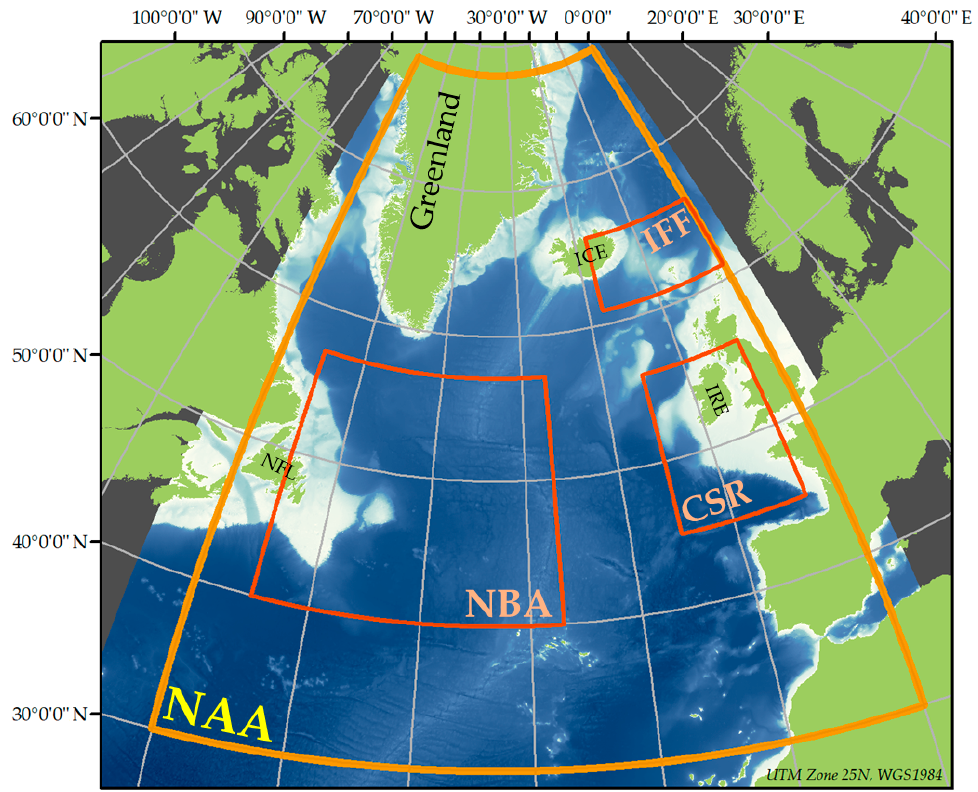
Figure 1. Map showing the study area, highlighting the four case study areas. These are the primary study region—the North Atlantic (NAA), and three smaller sub-regions—the Newfoundland Basin Area (NBA), the Iceland-Faroes Front region (IFF), and the Celtic Seas region (CSR). The bathymetry shown was obtained freely from GEBCO (www.gebco.net, accessed on 25 March 2021), with land and ocean area data distributed by Natural Earth (www.naturalearthdata.com, accessed on 25 March 2021).